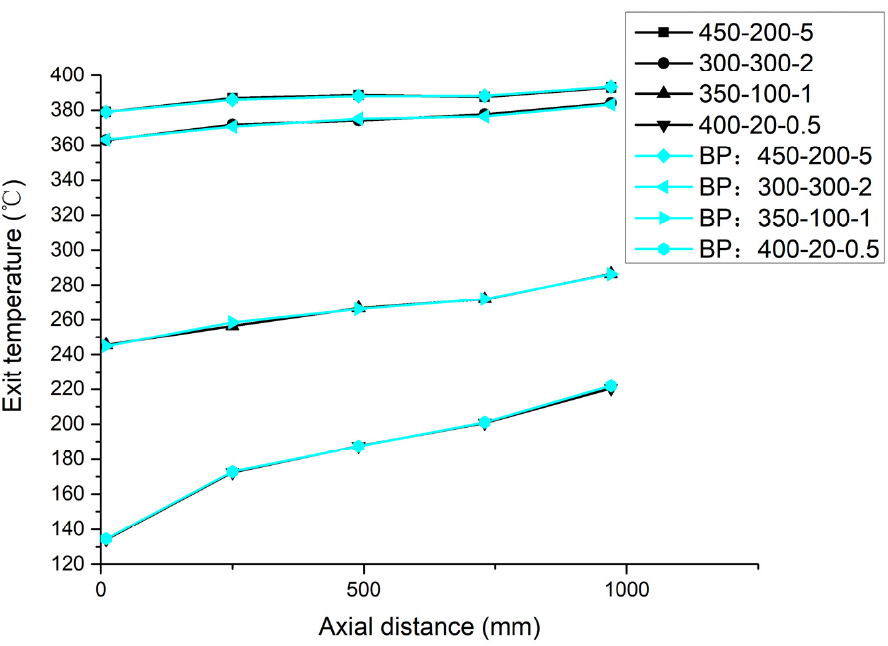
Figure 12. BP neural network predicted temperature versus experimental